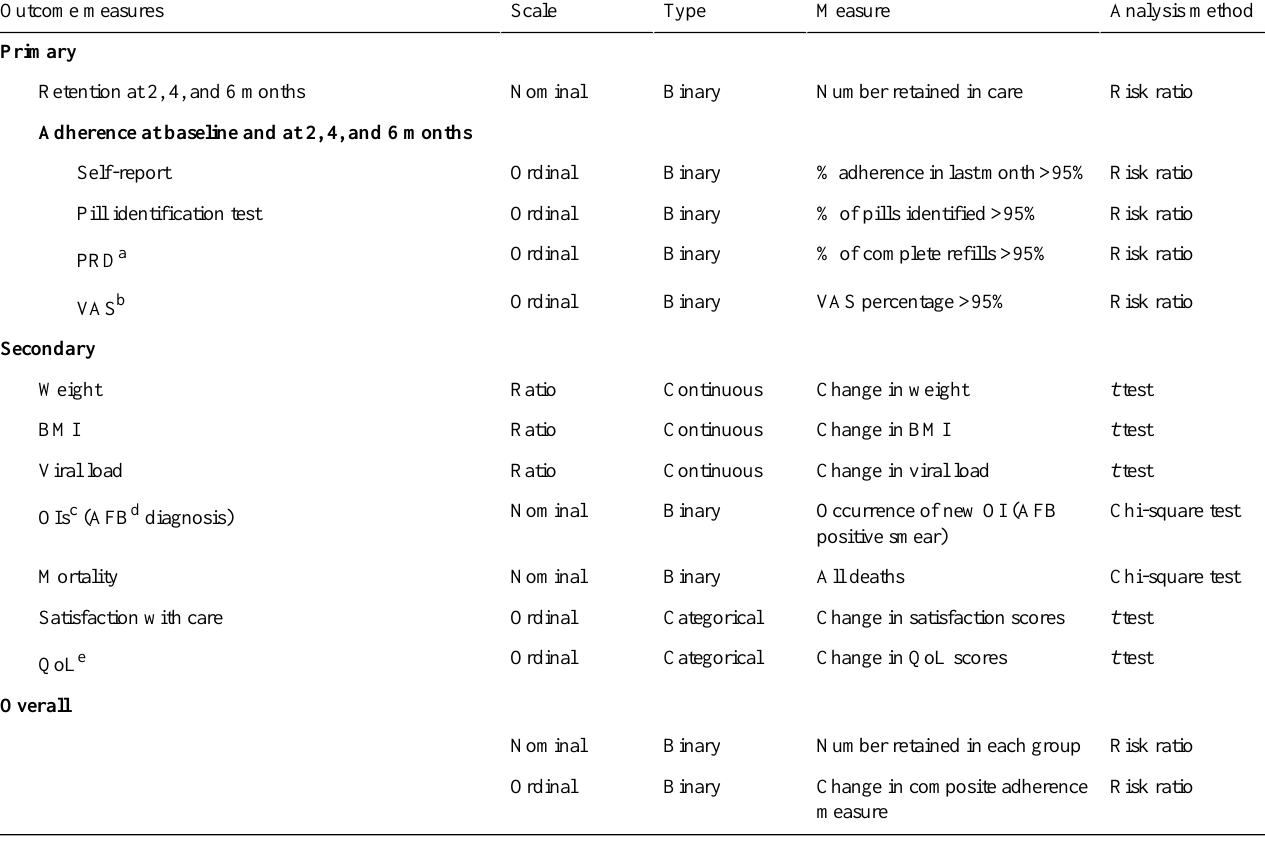
Table 1. Overview of outcome